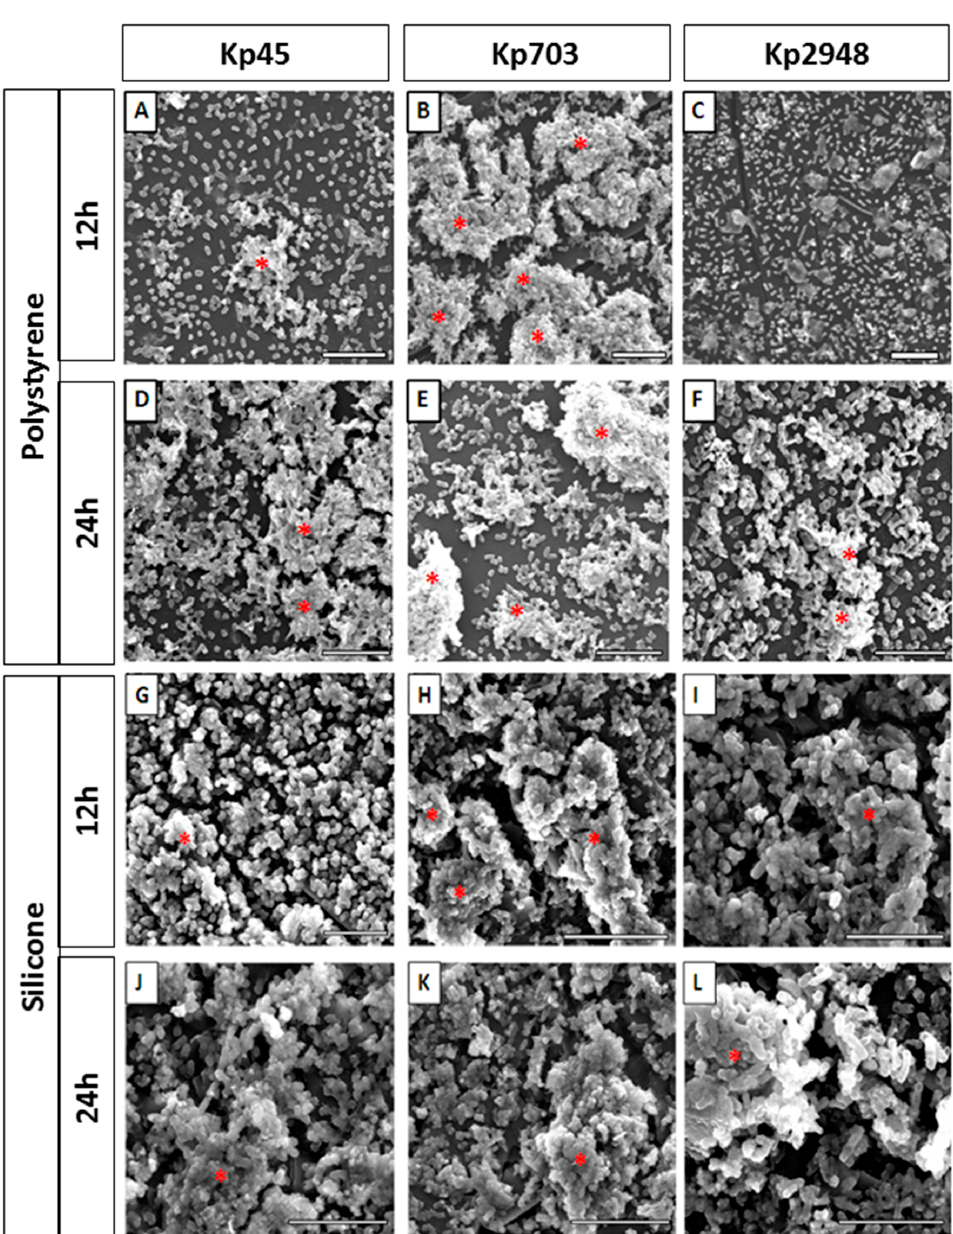
Figure 1. K. pneumoniae biofilms assembled on different surfaces: ( A – F ) representative